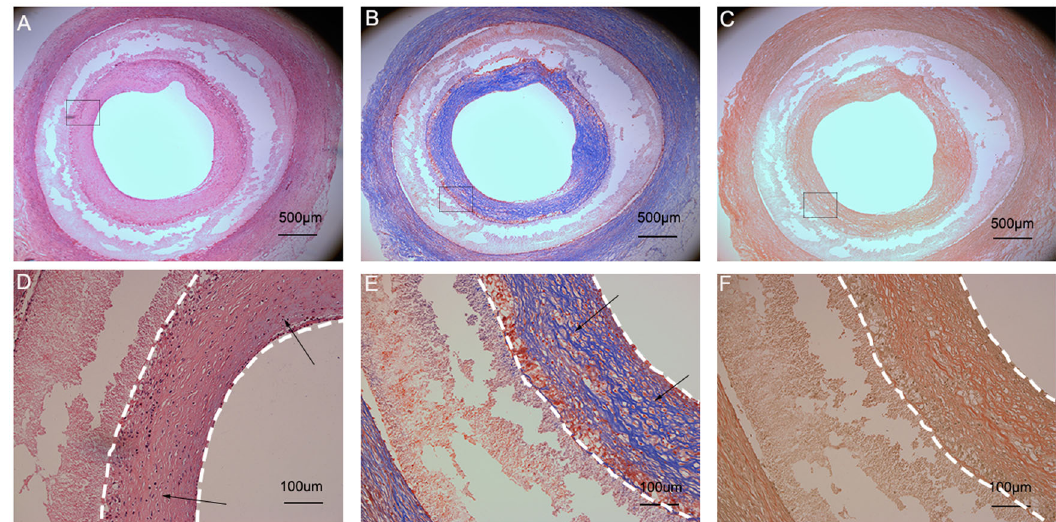
Fig. 10 Circumferential histological images of the biotube group stained with haematoxylin and eosin ( A ), Masson's trichrome ( B ), Elastica van Giessen ( C ) after 12 weeks of implantation (Partial enlarged area was labeled by the rectangle). Partial enlarged image of